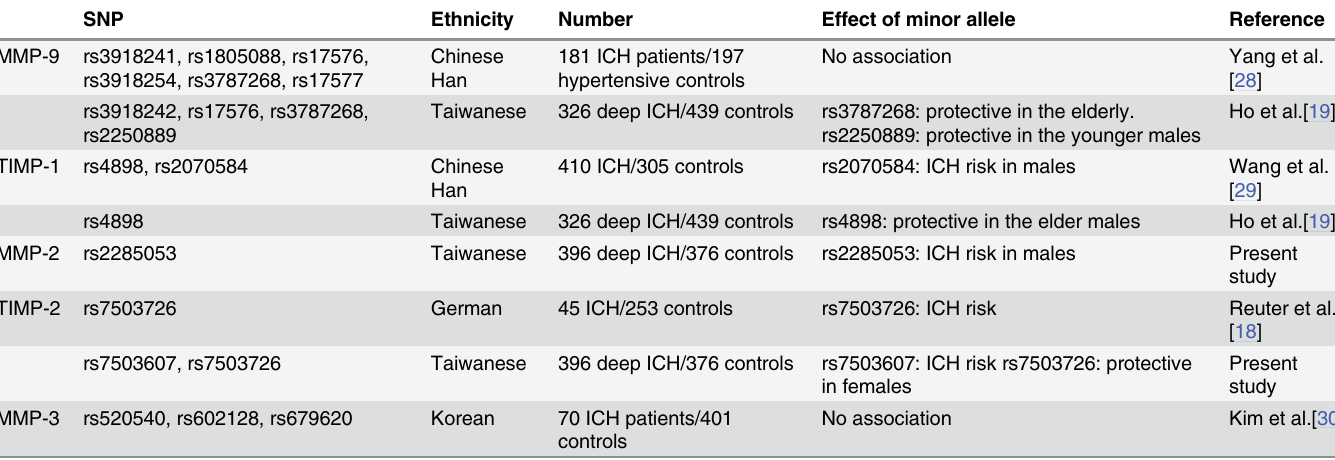
Table 5. Prior association studies of MMPs/TIMPs with ICH